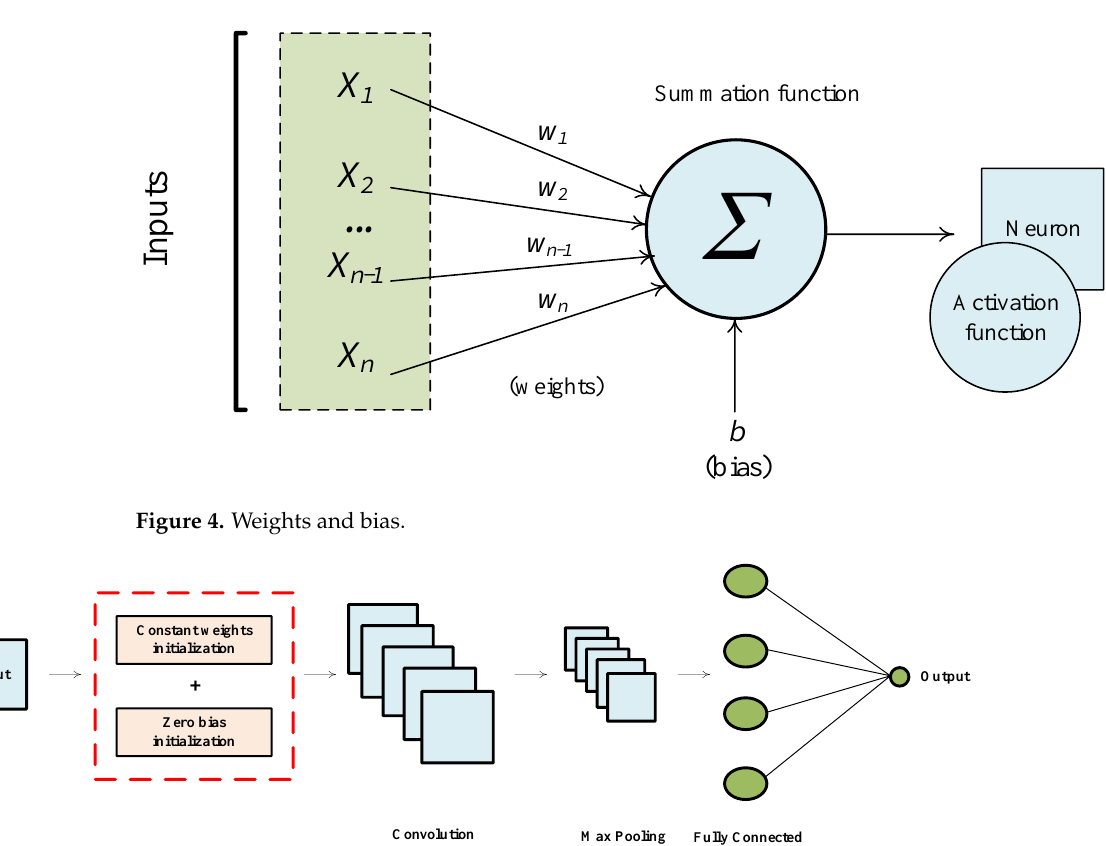
Figure 5. The architecture of proposed convolutional block optimization.